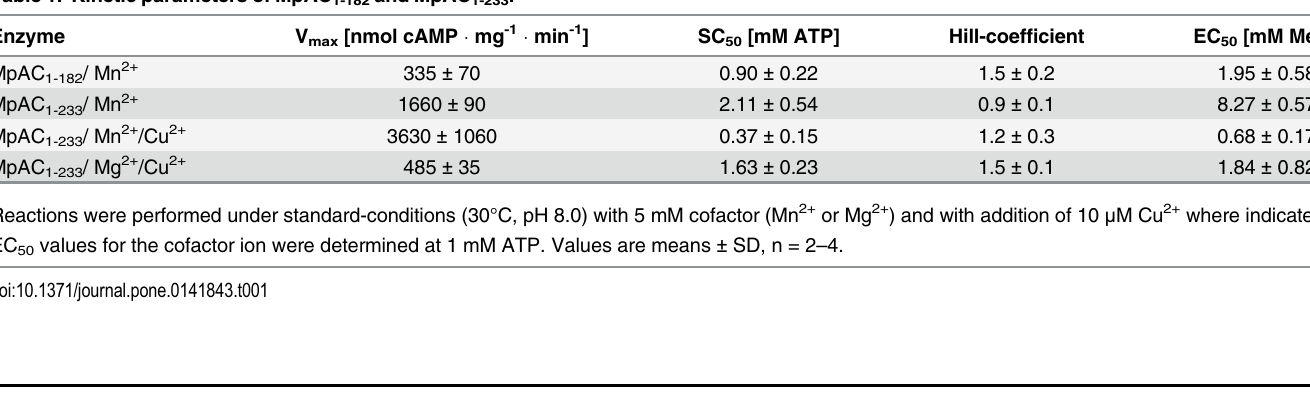
isolated CHD (Fig 3B, Table 1). In addition, MpAC did not show cooperativity with a Hill 1-233 showed a similar requirement for coefficient of 0.9 ± 0.1. The Mn 2+ -dependance of MpAC 1-233 . Yet, the affinity for Mn 2+ was lower for MpAC Mn 2+ in excess of ATP like that of MpAC 1-182 1- with an EC of 8.3 ± 0.6 mM free Mn 2+ (Fig 3C). The change in the kinetic parameters and 233 50 the Mn 2+ -affinity by the presence of the YHS-domain indicates that the YHS-domain has an impact on the conformation of the CHD even in the absence of transition-metal ions.